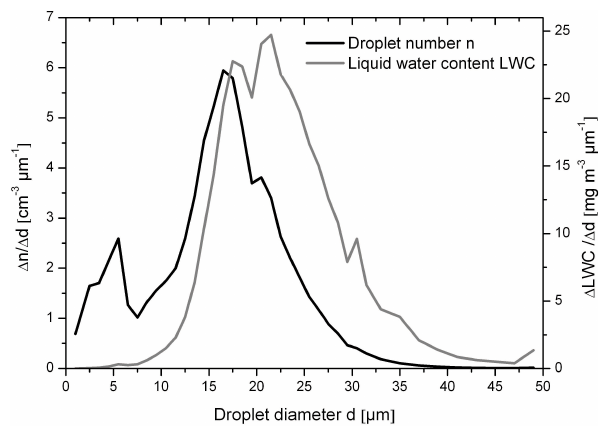
Fig. 1. Size distribution of the mean droplet number and the mean LWC for 11, 17 and 18 August